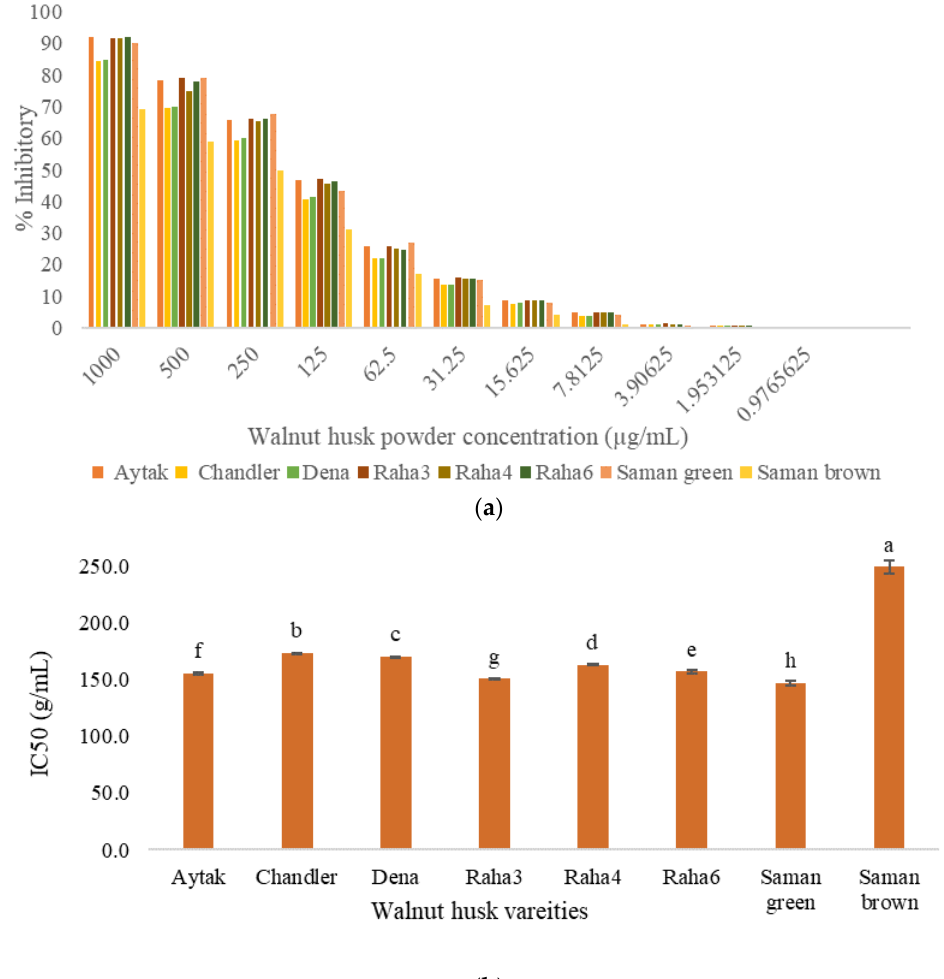
Figure 2. Antioxidant activity based on ( a ) the DPPH radical scavenging activity (inhibitory %) at different concentrations of husk powder, and on ( b ) the IC50 of various variants of walnut husk. Different letters in the same series indicate significant differences at the p < 0.05 level.